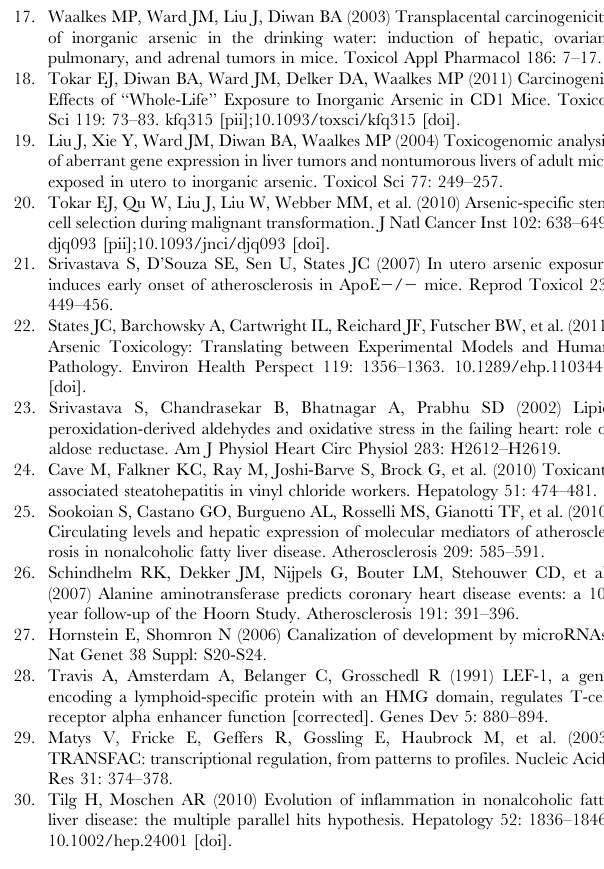
Table S8 Gene promoters of differentially expressed mRNAs that are targets of microRNAs induced in arsenic exposed PND1 mice were analyzed for transcription factor binding sites. A total of 49 unique Entrez gene IDs are gene targets of up regulated microRNA and appear in the gene list of differentially expressed mRNAs at PND1. A total 10 transcription factors are enriched for this gene set with a P-value , 0.05. Table S9 Gene promoters of differentially expressed mRNAs that are targets of microRNAs induced in arsenic exposed PND70 mice were analyzed for transcription factor binding sites. A total of 33 unique Entrez gene IDs are gene targets of up regulated microRNA and appear in the gene list of differentially expressed mRNAs at PND70. A total 13 transcription factors are enriched for this gene set with a P-value , 0.05. Table S10 Gene promoters of differentially expressed mRNAs that are targets of microRNAs suppressed in arsenic exposed PND70 mice were analyzed for transcription factor binding sites. A total of 124 unique entrez gene IDs are gene targets of down regulated miRNA and appear in the gene list of differentially expressed mRNAs at PND70. A total 21 transcription factors are enriched for this gene set.with a P-value , 0.05. Table S11 Gene promoters of differentially expressed mRNAs that are targets of microRNAs either induced or suppressed in arsenic exposed PND70 mice were analyzed for transcription